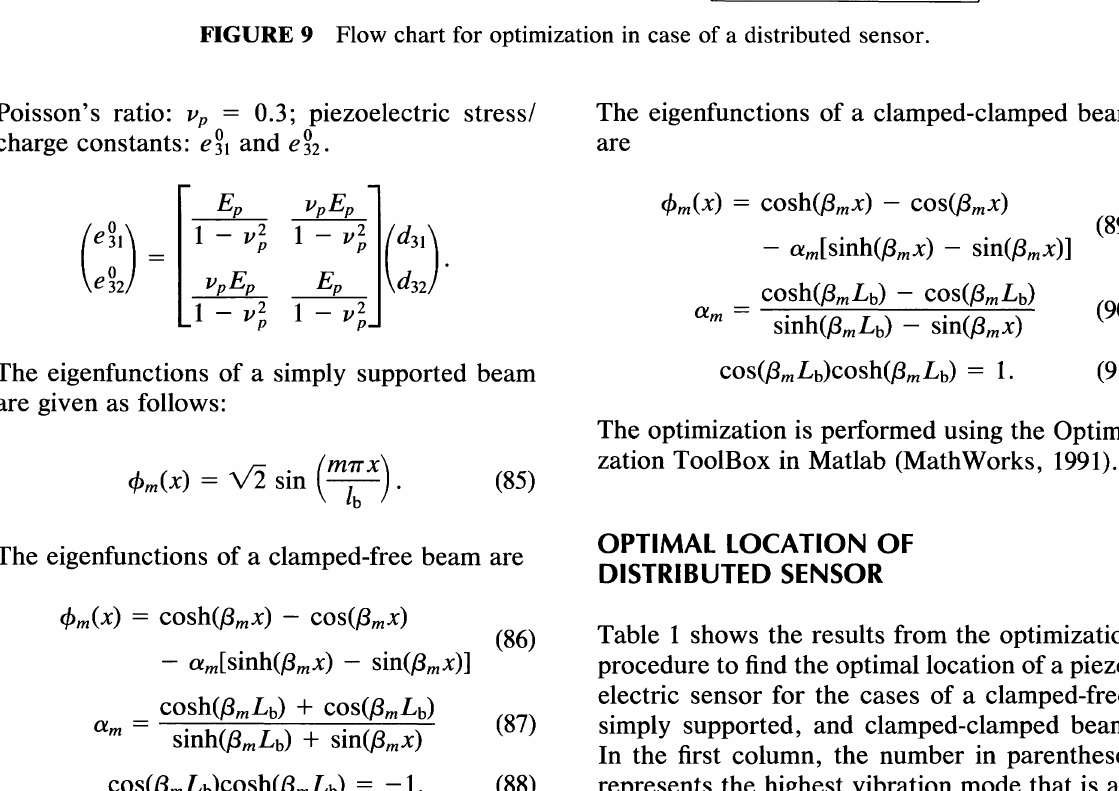
FIGURE 9 Flow chart for optimization in case of a distributed